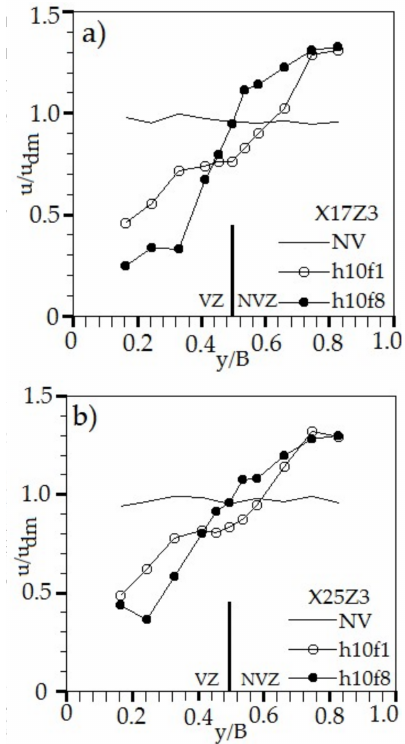
Figure 11. Non-dimensional streamwise velocity distributions along the spanwise direction at z / h v = 0.5 for h v = 0.1 m and different SVFs; ( a ) X17; ( b ) X25.